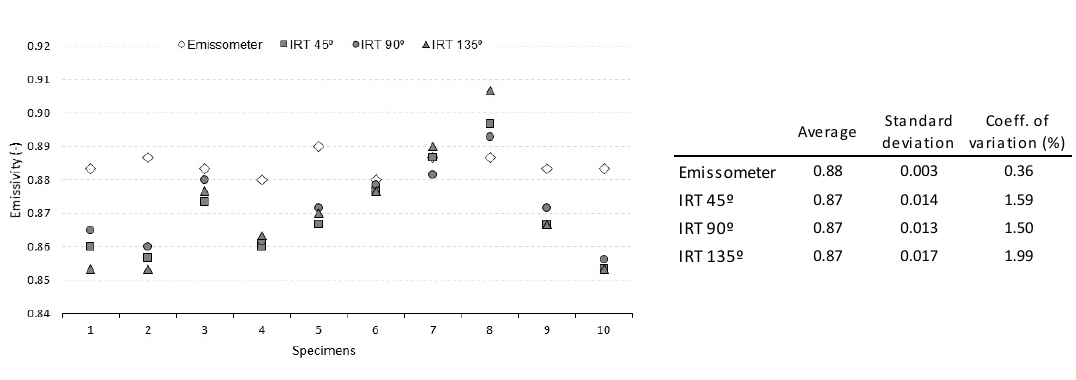
Figure 2. Emissometer versus infrared thermography (for each specimen and method the result is the average of three measurements).